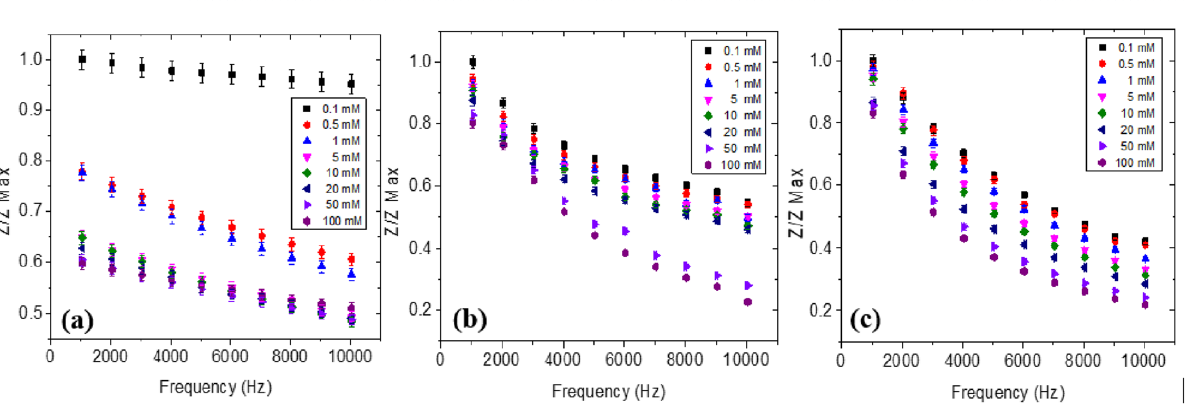
Figure 2. ( a ) FeSEM images of F-MWCNT ( a1 ), F-MWCNT/ZnO-NFs composites with proportion of 1:1 ( a2 ), 1:3 ( a3 ), 1:5 ( a4 ) and ( b ) X-ray diffraction (XRD) spectrum for ZnO, F-MWCNT, F-MWCNT/ZnO-NFs.